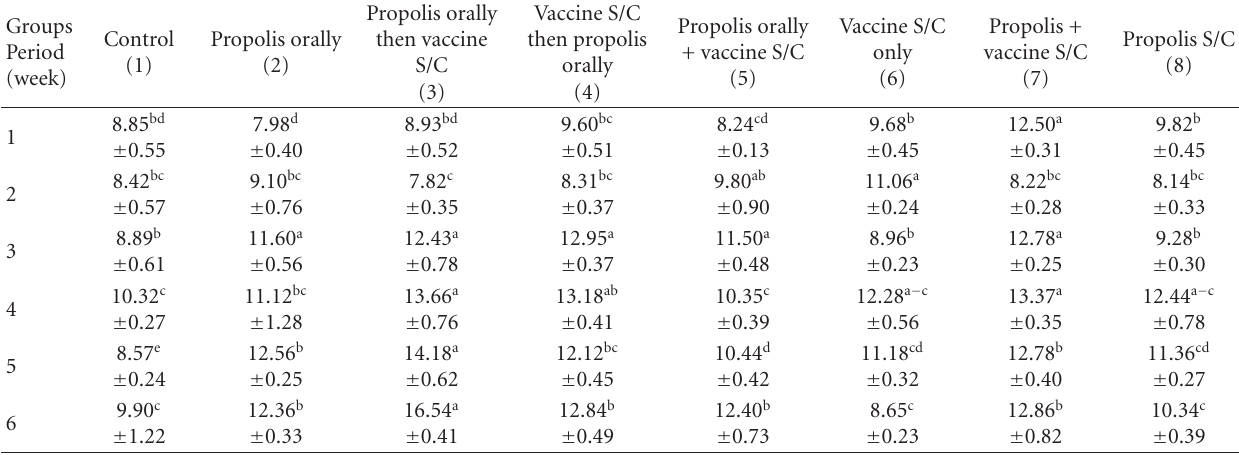
Table 1: Total leukocytes count ( × 10 3 / μ L) in di ff erent experimental groups of rabbits received propolis and vaccine treatments for six weeks (mean ± SE).